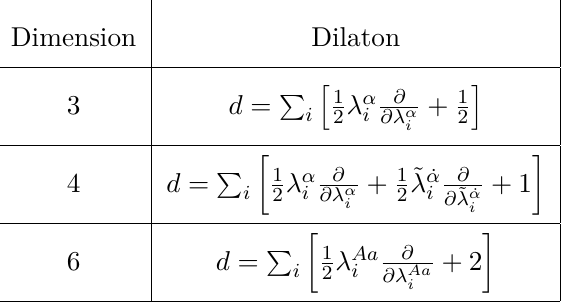
Table 1 . Dilatons in various dimensions [15, 20,